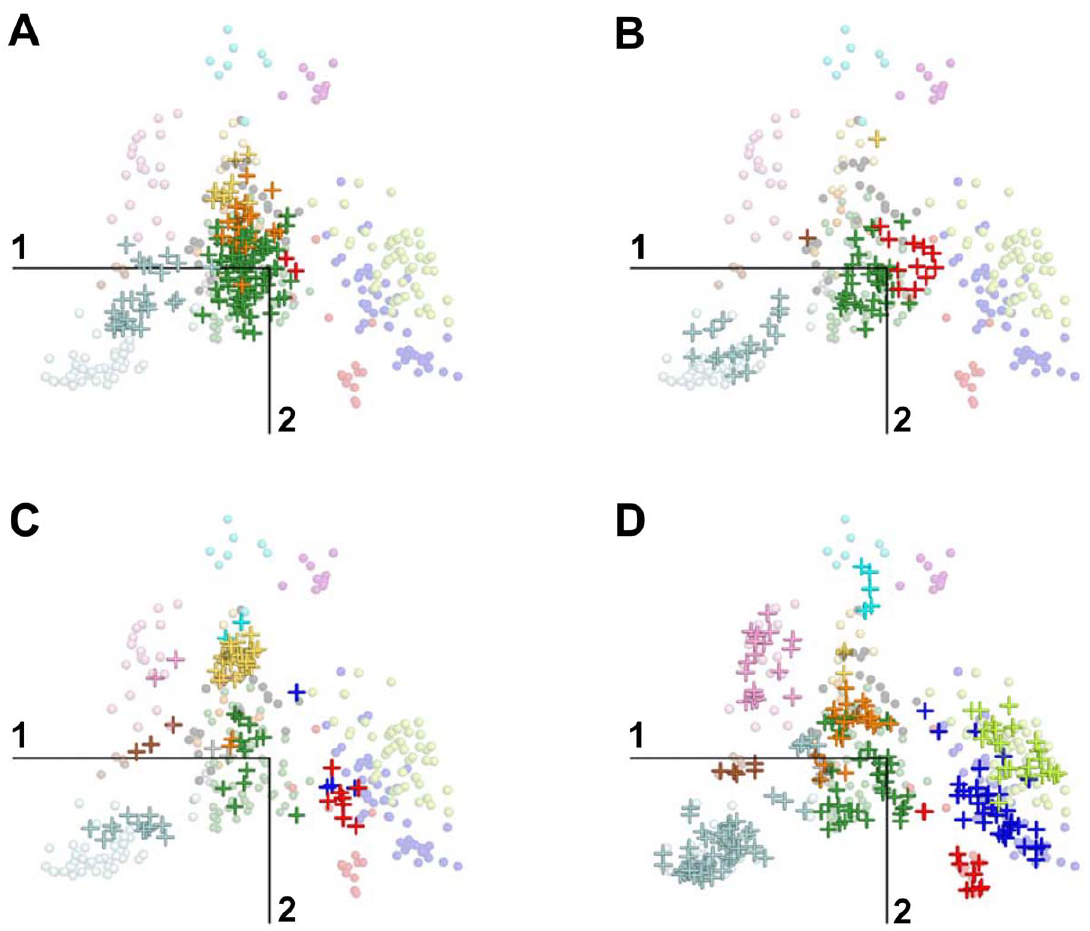
Figure 4. Projection of supplementary GPCR sequences onto the sequence space of human GPCRs. GPCRs from N. vectensis (A), C. elegans (B), C. intestinalis (C) and D. rerio (D) are projected onto the plane formed by the first two components of the human active space. Transparent circles and crosses represent human and supplementary elements, respectively. The color code refers to the GPCR sub-families (AD: brown; AMIN: light blue; CHEM: dark blue; LGR: yellow; MEC: pink; MTN: grey; MRG: violet; OPN: orange; PEP: dark green; PTG: cyan; PUR: light green; SO: red; UC: black).